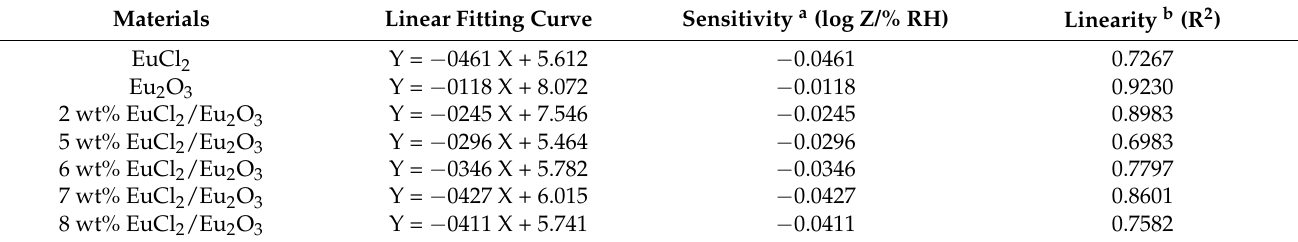
Table 1. Sensitivity and linearity of impedance-type humidity sensors based on EuCl 2 , Eu 2 O 3 and EuCl 2 /Eu 2 O 3 blend films. Materials Linear Fitting